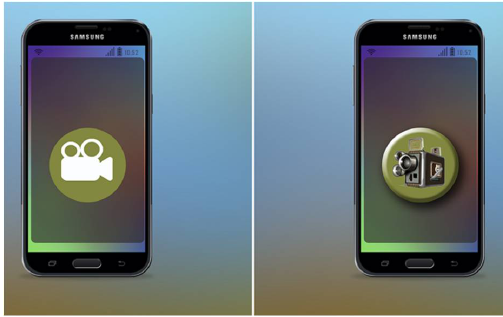
Figure 2. Screens displayed to users in Step 2 (recall the icon).